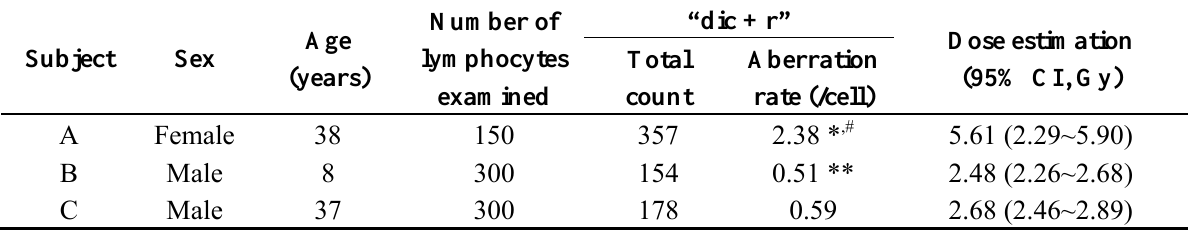
Table 1. Chromosome aberration analysis and biological dose estimation.